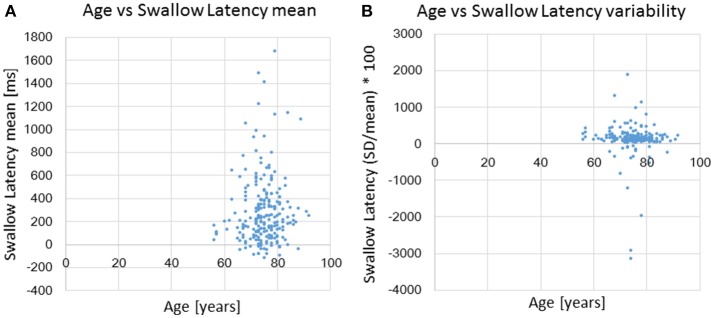
The relationships between age and swallowing latency (A) and age and coefficient of variation [(SD/mean) * 100] of swallowing latency (B).